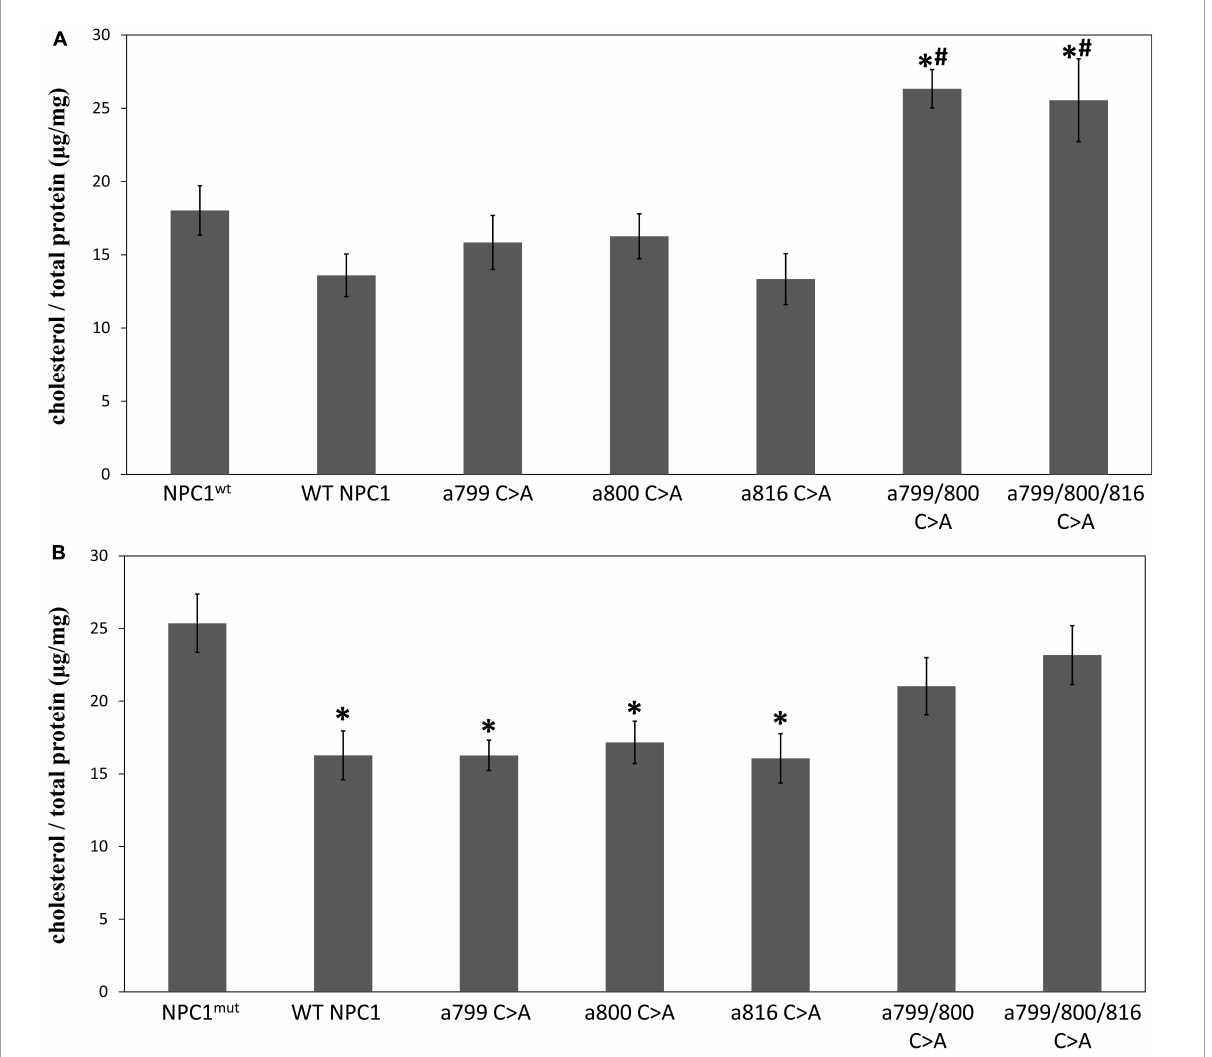
FIGURE5 The effect of mutated NPC1 proteins on cholesterol accumulation. Intracellular cholesterol levels were measured as described and expressed as µ g per mg total cellular protein. (A) NPC1 wt cells were transfected with pcDNA3.1 containing wildtype (WT NPC1) or mutated NPC1 cDNA at the indicated positions. ∗ Indicates a significant difference when compared to NPC1 wt ( p < 0.05 by unpaired t -test, the same for the rest of the comparisons). # Indicates a significant difference when compared to WT NPC1. (B) NPC1 mut cells were transfected with pcDNA3.1 containing wildtype (WT NPC1) or mutated NPC1 cDNA at the indicated positions. ∗ Indicates a significant difference when compared to NPC1 mut . The transfection experiments were repeated three times with triplicated wells each time and the cholesterol levels were measured in duplicates. The average value for each condition was calculated and presented. Error bars stand for standard error